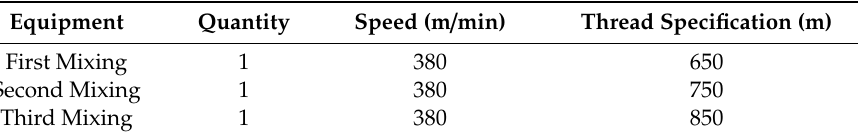
Table 5. 55% / 45% product process parameters.